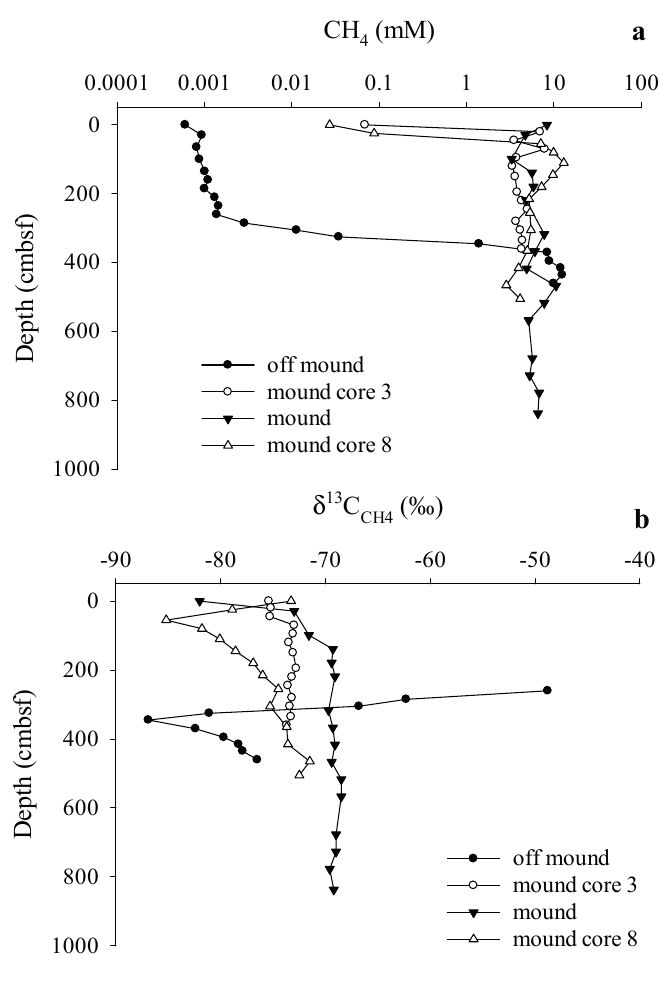
Figure 5. ( a ) Sediment CH 4 concentrations; and ( b ) δ 13 C CH4 values measured for on-mound (C7) and off-mound (C2) core locations. On-mound cores include cores 3 and 8 that are used for estimating the C isotope values for source CH 4 and interpretation of mound C cycling.